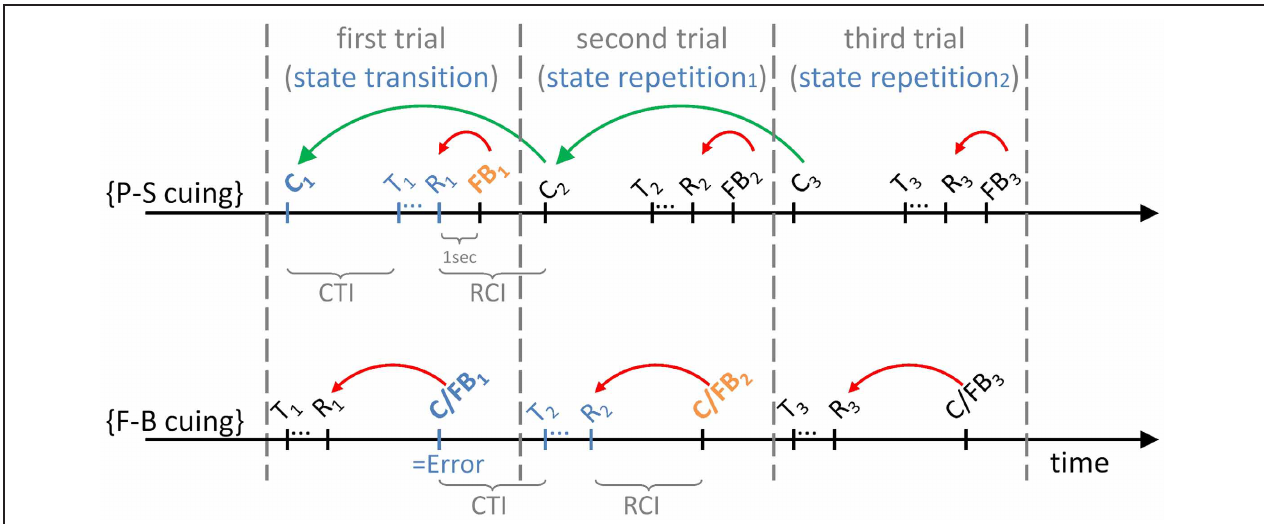
FIGURE 2 | The temporal sequence of events on P-S cuing and on F-B cuing conditions. The figure illustrates the initial three trials of task runs. C x , task cue on trial x { x = 1 ... 3 } ; FB x , feedback stimulus on trial x { x = 1 ... 3 } ; C/FB x , hybrid cue/feedback stimulus on trial x { x = 1 ... 3 } ; T x , target stimulus on trial x { x = 1 ... 3 } ; R x , response on trial x { x = 1 ... 3 } . CTI, cue-target interval (3s); RCI, response-cue interval (3s). Curved arrows indicate the contingencies: C x -cues inform about possible state transitions, i.e., the currently effective task relative to the task that was effective on the previous trial on the P-S cuing condition; additional FB x -feedback stimuli